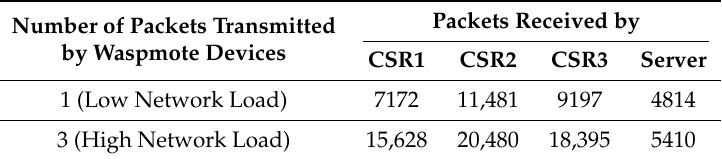
Table 10. Number of packets received by CSR devices and BLE server for each Waspmote device configuration in Individual Mesh with CSR devices retransmit each packet once.